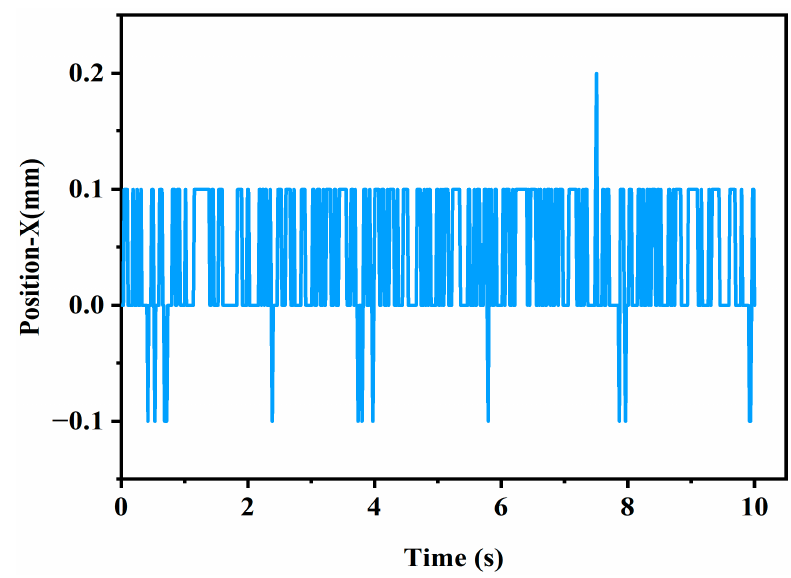
Figure 6. The positioning data of the tracker in the X direction.